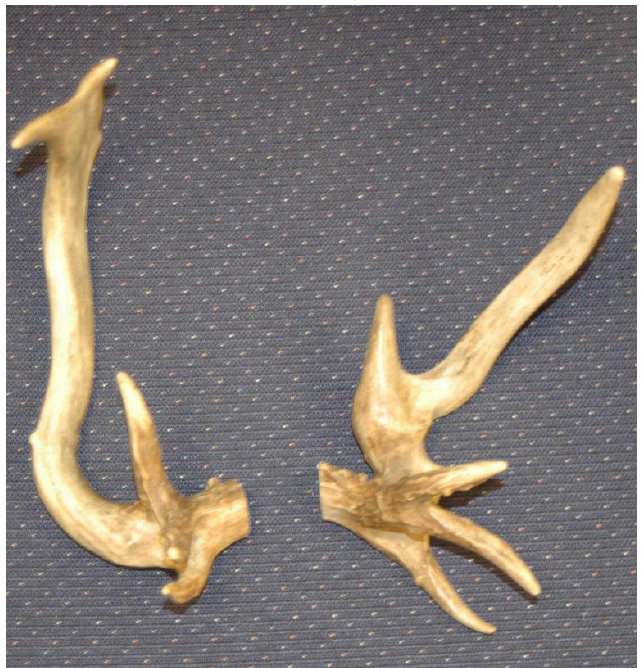
Figure A2. Antlers of a male white-tailed deer ( Odocoileus virginianus ) displaying malformed antlers in the absence of pedicle damage. Photograph by Stephen L. Webb.